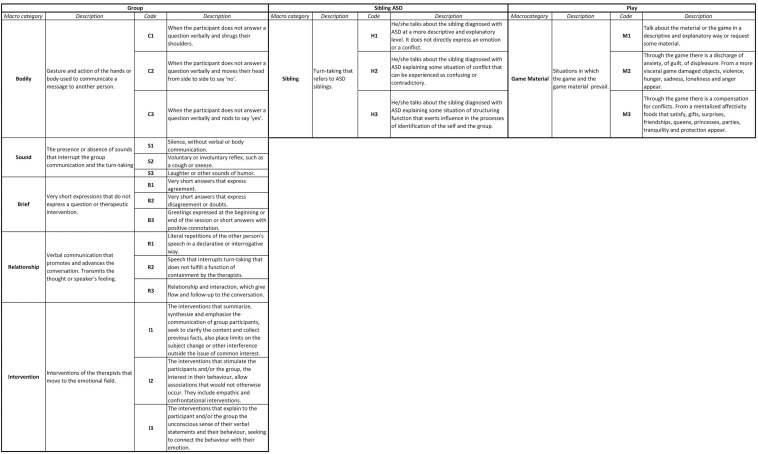
Code description.